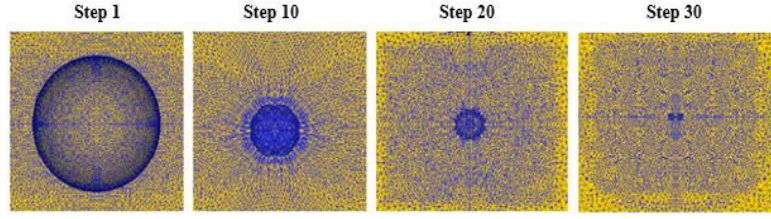
Figure 6. Closure law of void in steel ball.